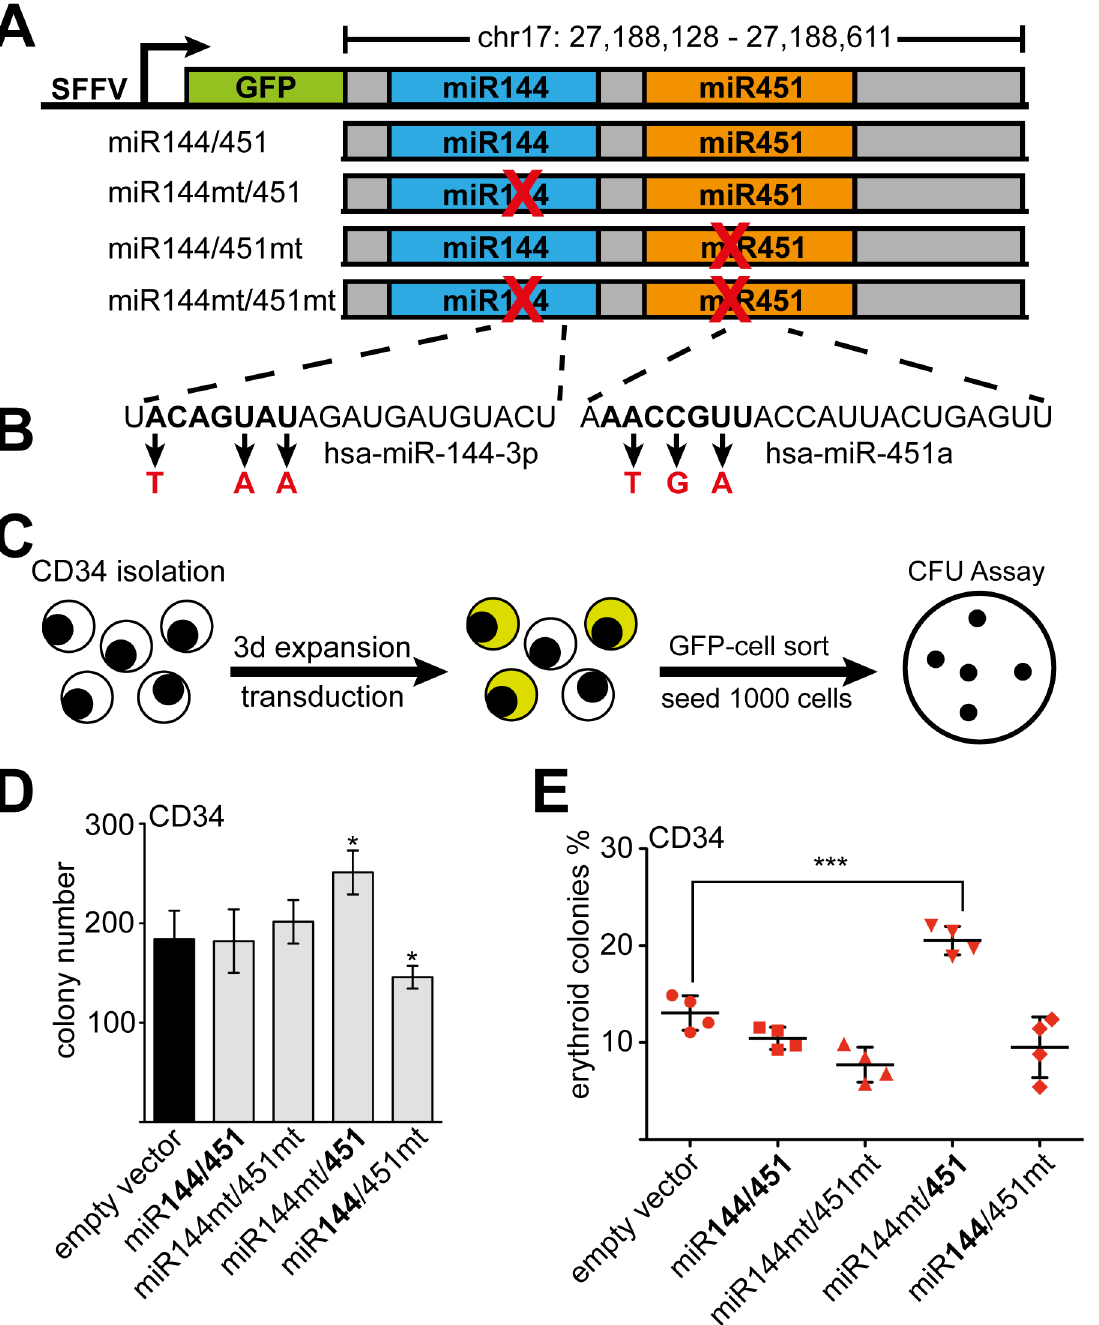
Fig 4. MiR451 increases erythroid differentiation. (A) Schematic representation of miR144/451 expression constructs. The genomic sequence of human miR144/451 was cloned into the LEGO vector [48] behind the GFP expression cassette, which is driven by a spleen focus-forming virus promoter. The wild type and mutant constructs are shown, with the X marking the mutational site. (B) The mutations introduced in the seed sequences of miR144 and miR451 are indicated. (C) A colony formation assay was performed with sorted GFP-positive transduced hCD34+ cells. (D) The total number of colonies in the colony formation assay is shown. Colonies were counted on day 12. E) The frequency (%) of erythroid colonies among total colonies in the colony formation assay is shown. Error bars represent the standard deviation of four independent determinations. * P-value < 0.05, *** P-value < 0.001 according to Student ’ s t test.